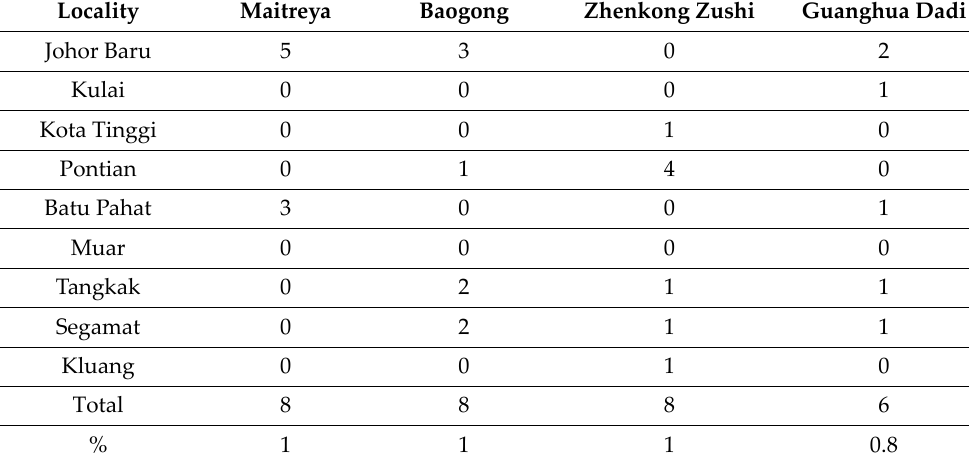
Table 14. Main Deity and Their Distribution in Each District